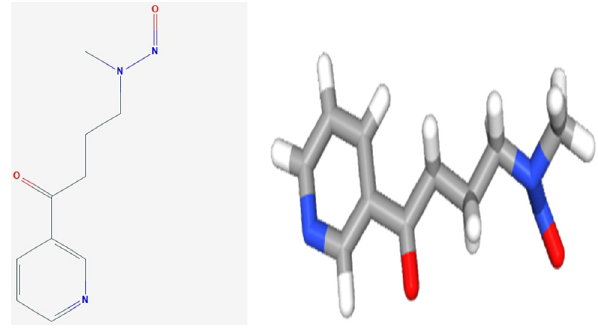
Figure 2: Shows the 2D and 3D structures of ( NNK )